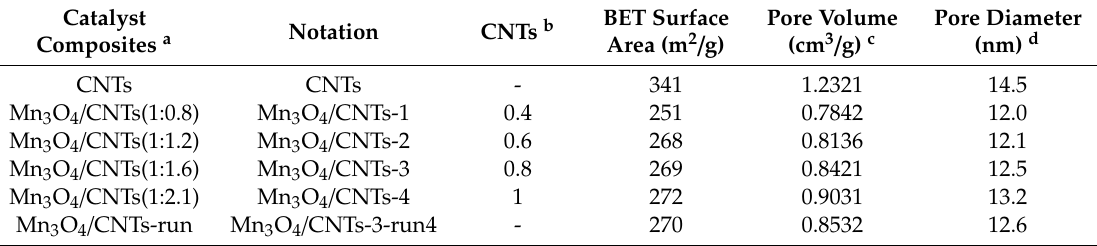
Table 1. BET surface area of CNTs and Mn 3 O 4 /CNTs catalysts.